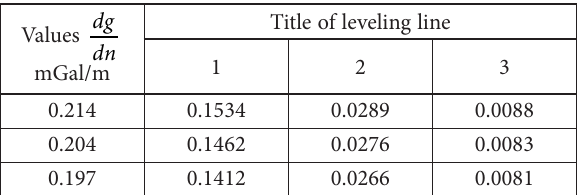
Table 2. Values of these corrections f ,